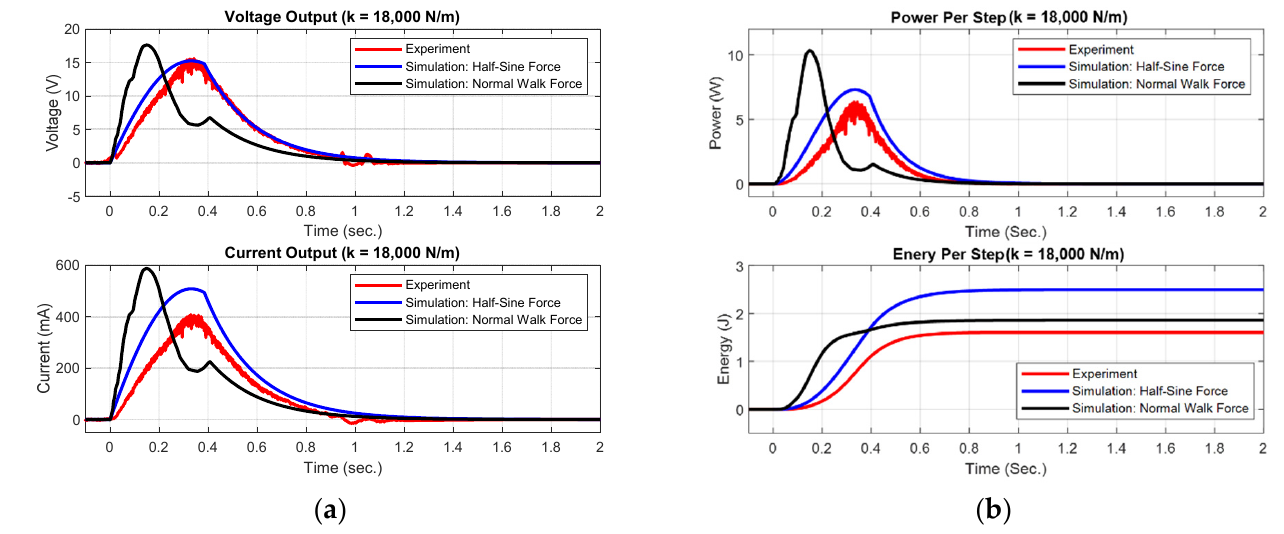
Figure 3. Input footstep force.